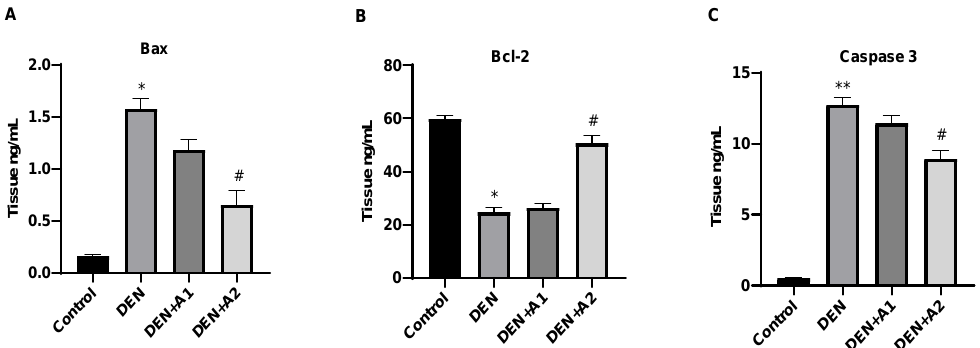
Figure 4. Effects of artichoke on A) Bax (Tissue ng/ml), B) Bcl-2 (Tissue ng/ml), and C) caspase-3 (Tissue ng/mL) levels in brain tissue ( n = 8). Data are presented as means ± SD * p < 0.05, ** p < 0.001 vs. control group, # p < 0.05 vs. DEN group; DEN: diethylnitrosamine, A1: 0.8 g/kg artichoke, A2: 1.6 g/kg artichoke.